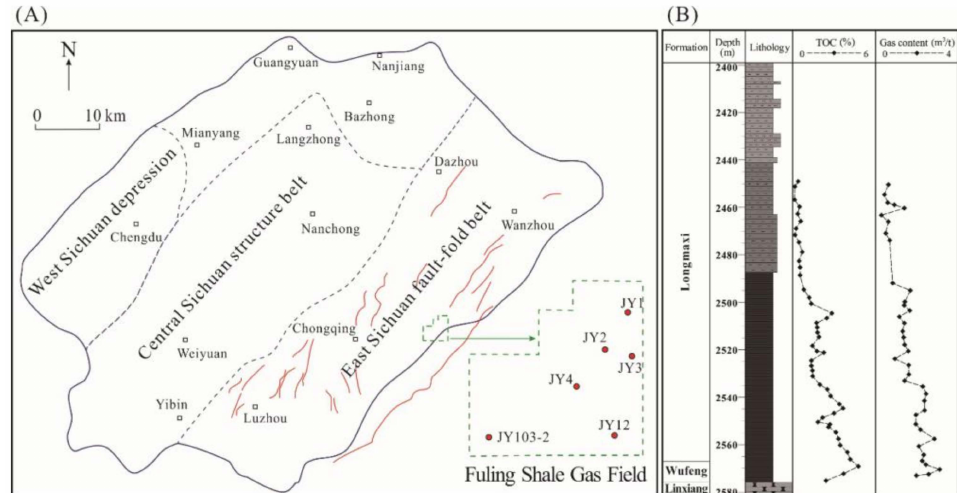
Figure 2. ( A ) Location of the Fuling shale gas field in the Sichuan Basin. ( B ) Lithological profile of Well JY2 in the Fuling shale gas field. The gas content data were calculated according to the USBM “Direct Method”.